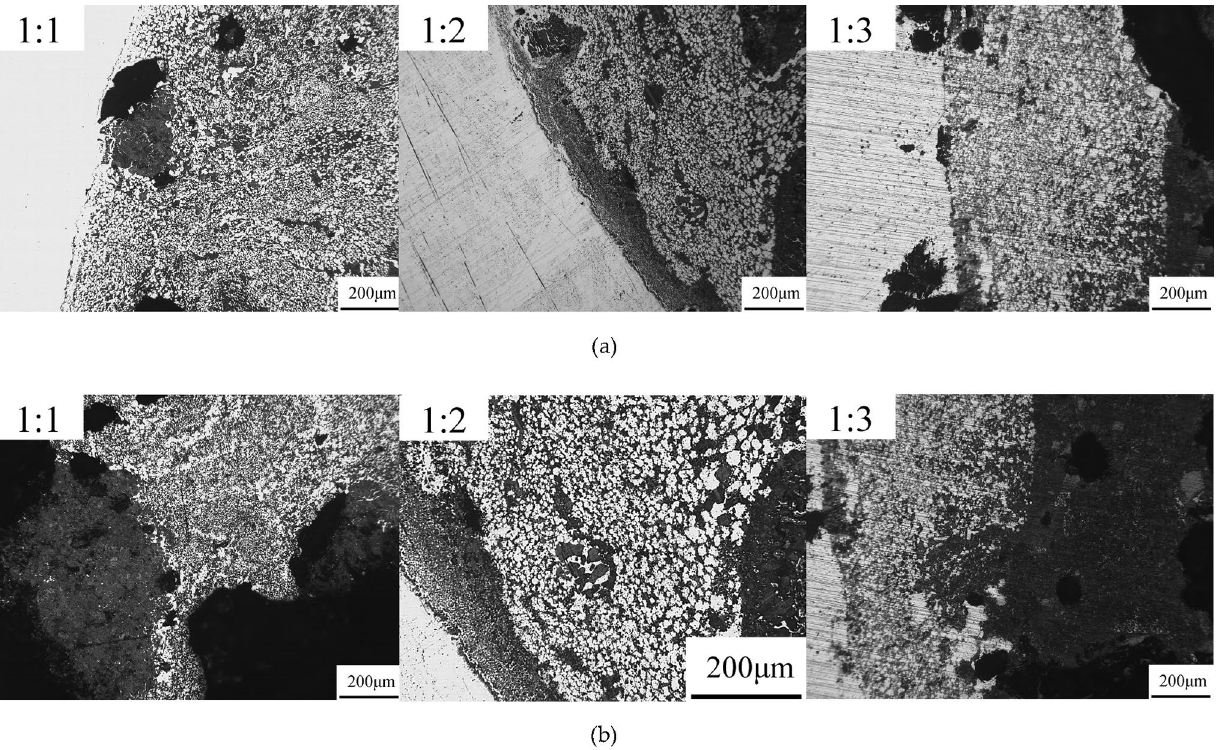
Figure 2. Metallographic pictures of atoms at different atomic ratio, ( a ) Pictures of the cylinder block’s neighboring area, ( b ) Pictures around its core area.